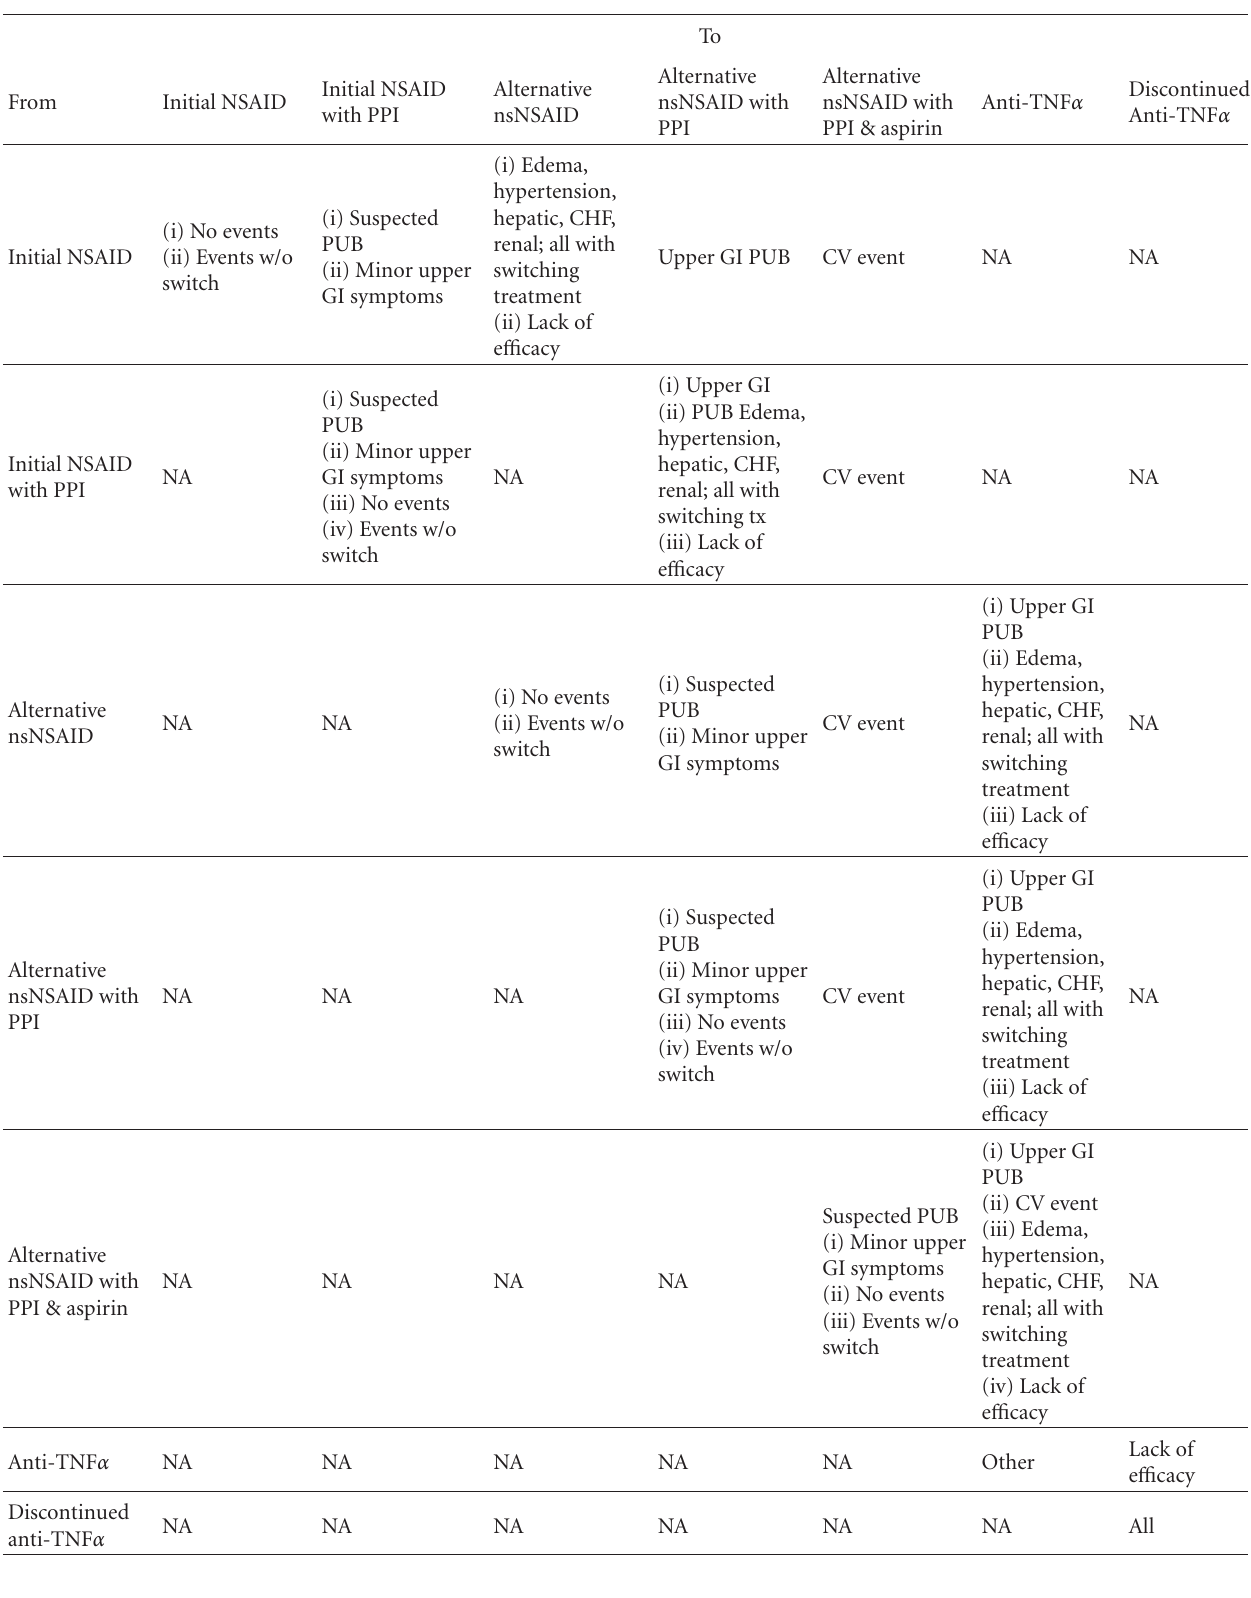
Table 1: Transitions between di ff erent health states of Markov model due to events and lack of e ffi cacy.